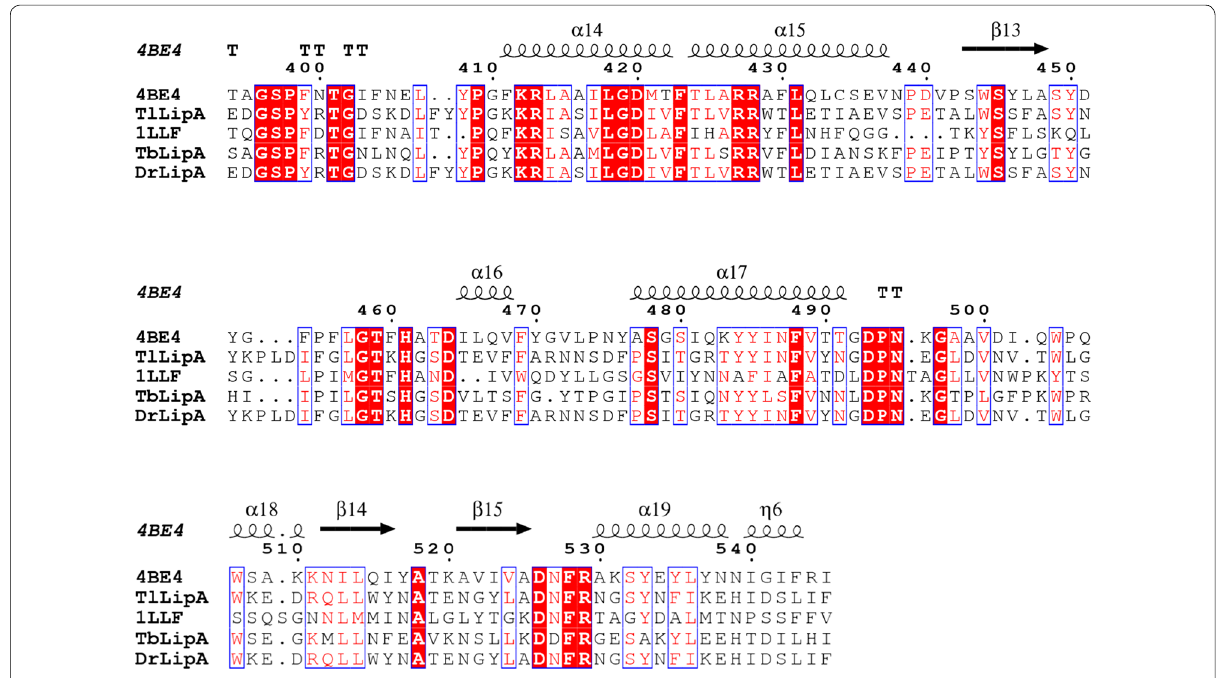
Fig. 3 Multiple sequence alignment of deduced Tl LipA with structure-resolved lipases 4BE4 from Ophiostoma piceae and 1LLF from Candida cylindracea as well as biochemically characterized lipases Tb LipA from Trichophyton benhamiae and Dr LipA from Diutina rugosa . The secondary structural elements are indicated